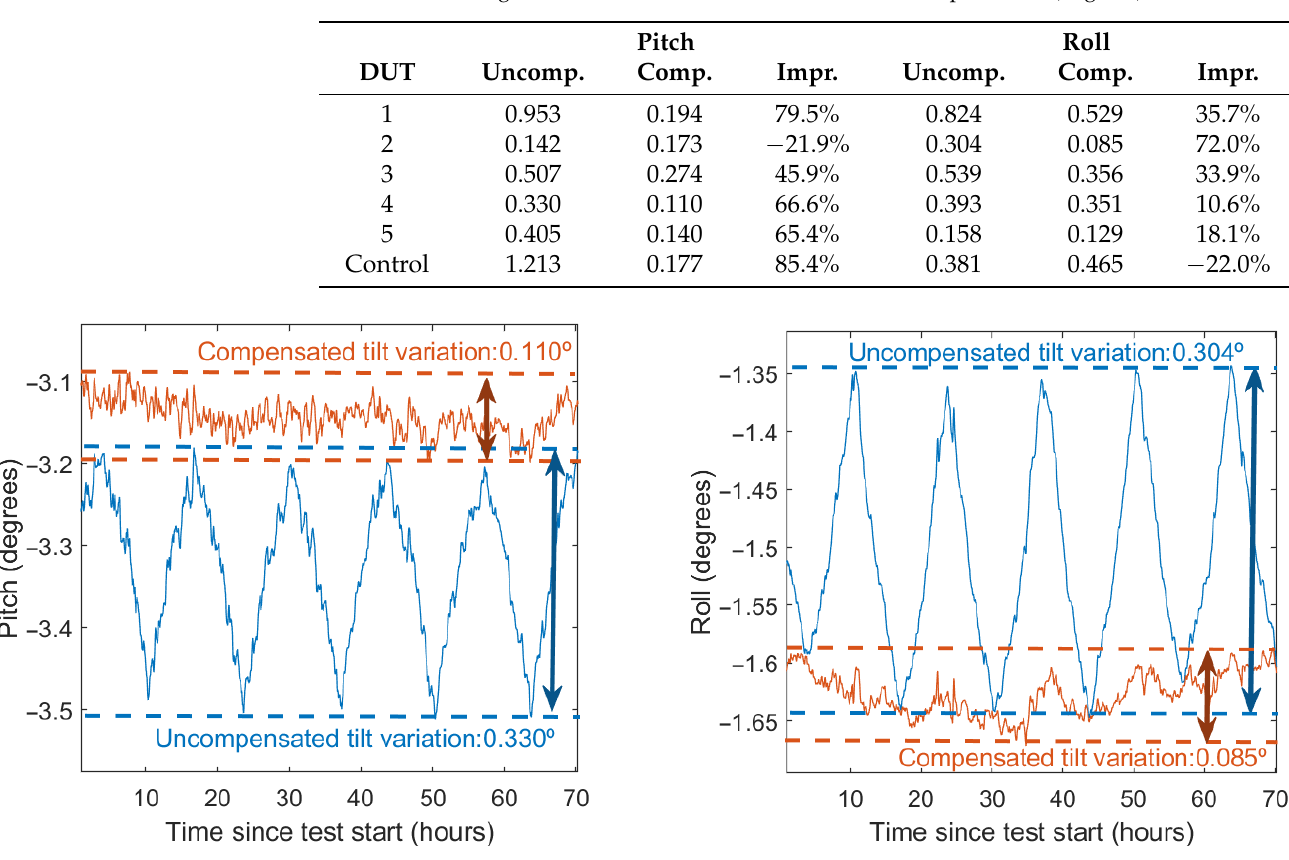
Table 10. Euler angles max error deviation before and after compensation (degrees).